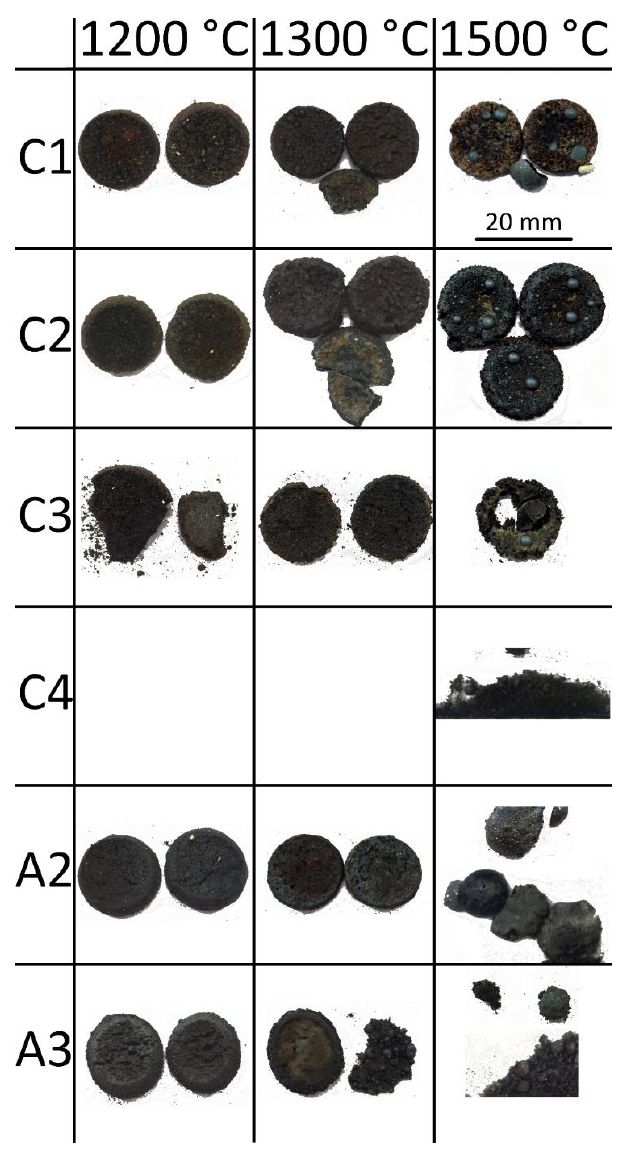
Figure 5. Overview of some of the samples obtained after reduction in a muffle furnace.